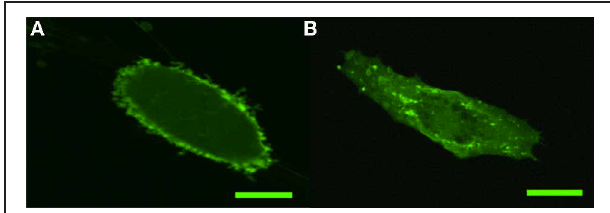
FIGURE 1 | Confocal imaging of PH-PLC-GFP expression pattern in HSF and BAEC. (A) Characteristic PH-PLC-GFP expression in HSF. (B) Characteristic PH-PLC-GFP expression in BAEC. Scale bars: 20 μ m.